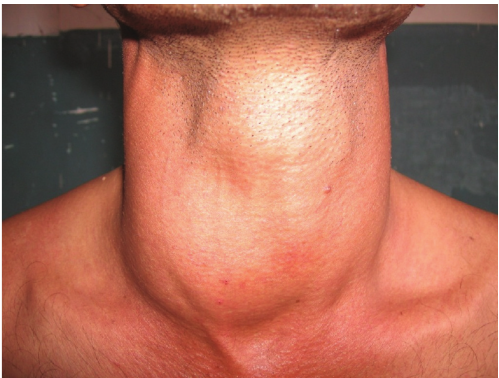
Figure 1: The patient presented diffuse smooth swelling of the right lobe of the thyroid.